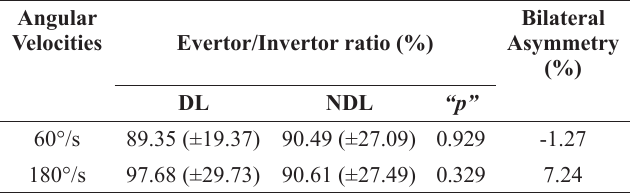
DL = dominant limb, NDL = non-dominant